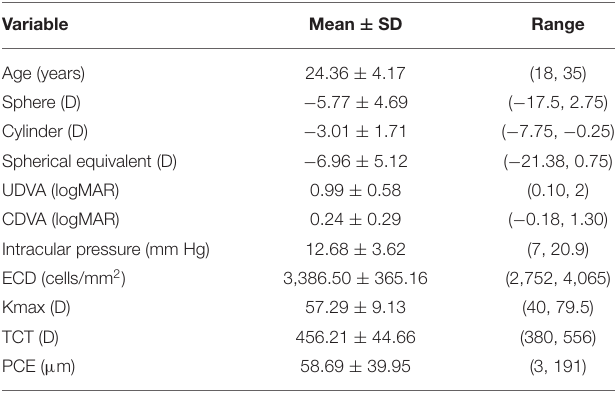
TABLE 1 | Pre-operation characteristics of enrolled keratoconus patients.